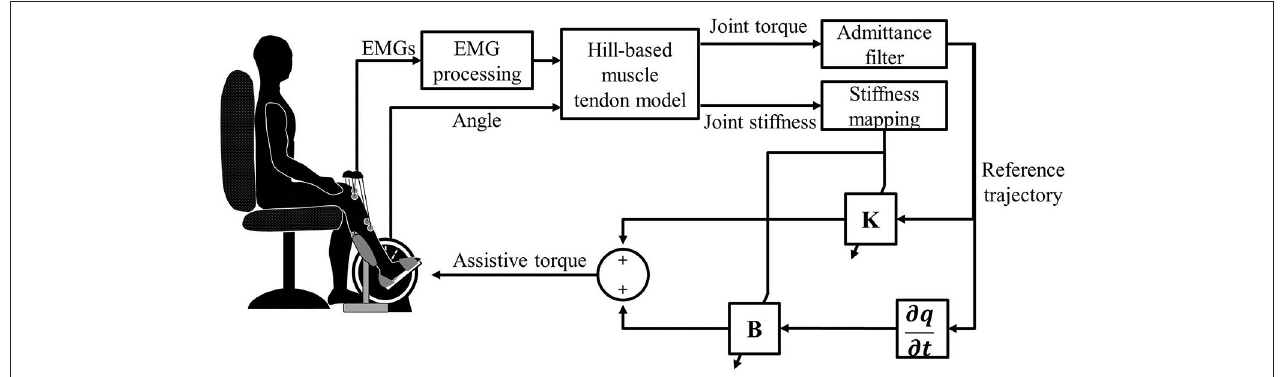
FIGURE 3 | The control diagram of the ankle rehabilitation